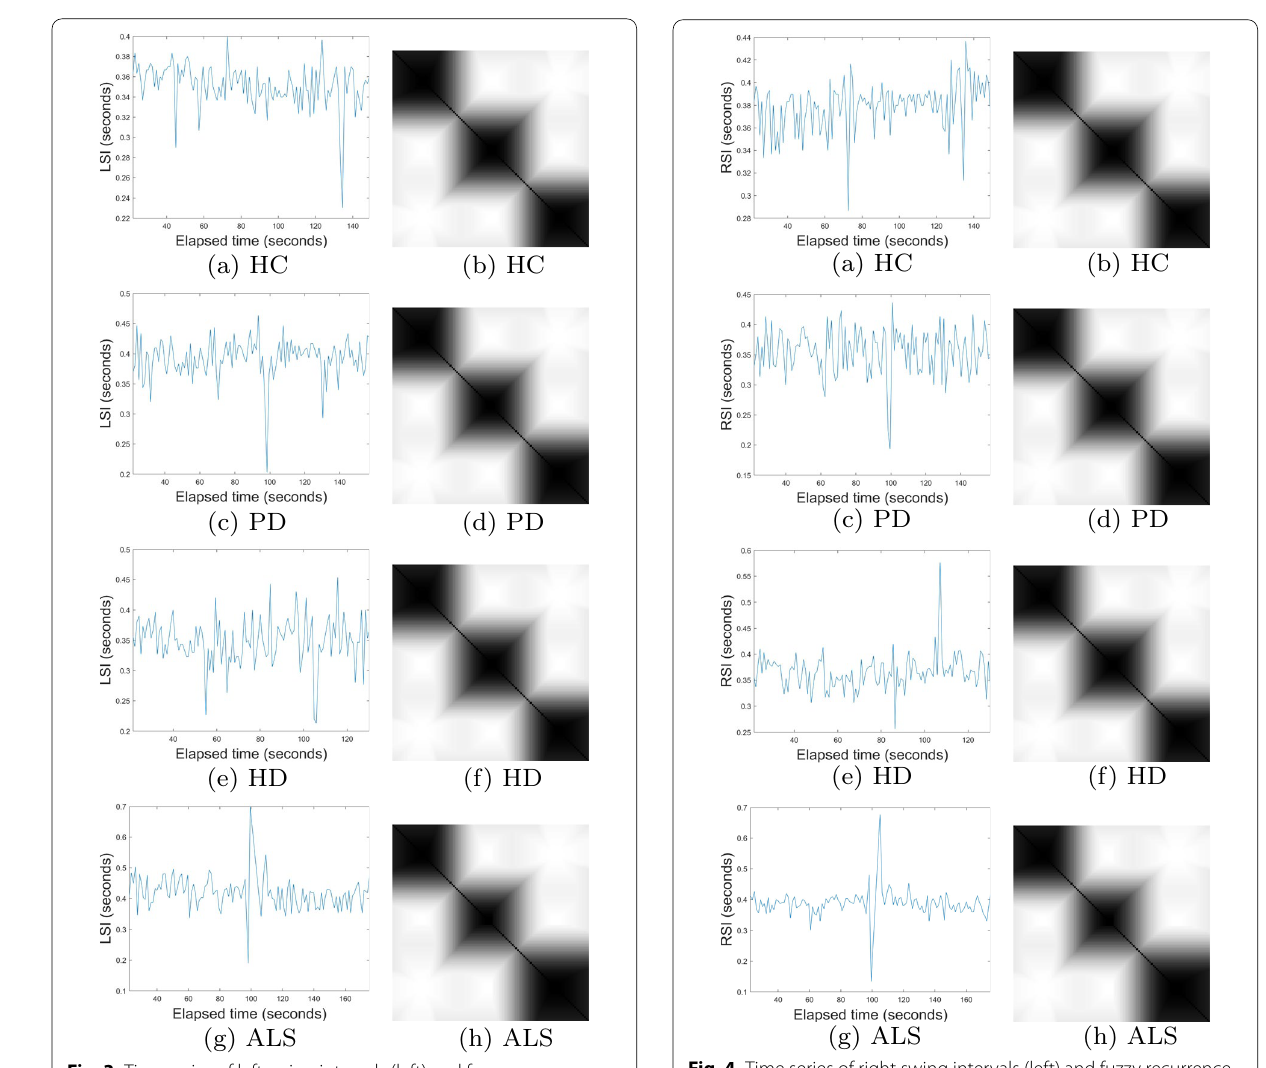
Fig. 3 Time series of left swing intervals (left) and fuzzy recurrence plots (right) of healthy control and neurodegenerative subjects